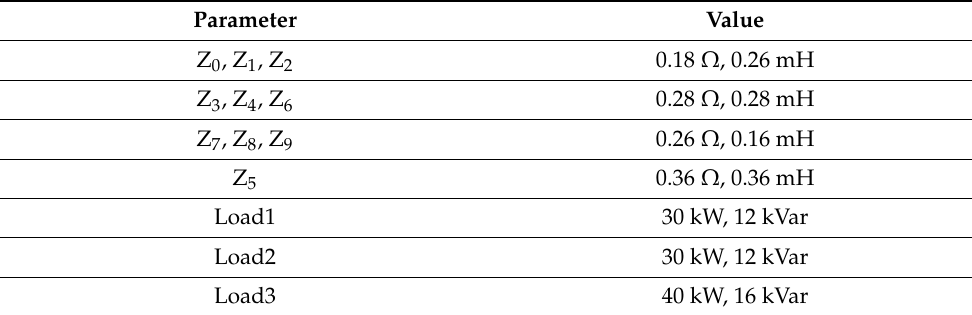
Table 4. The electrical parameters in a large